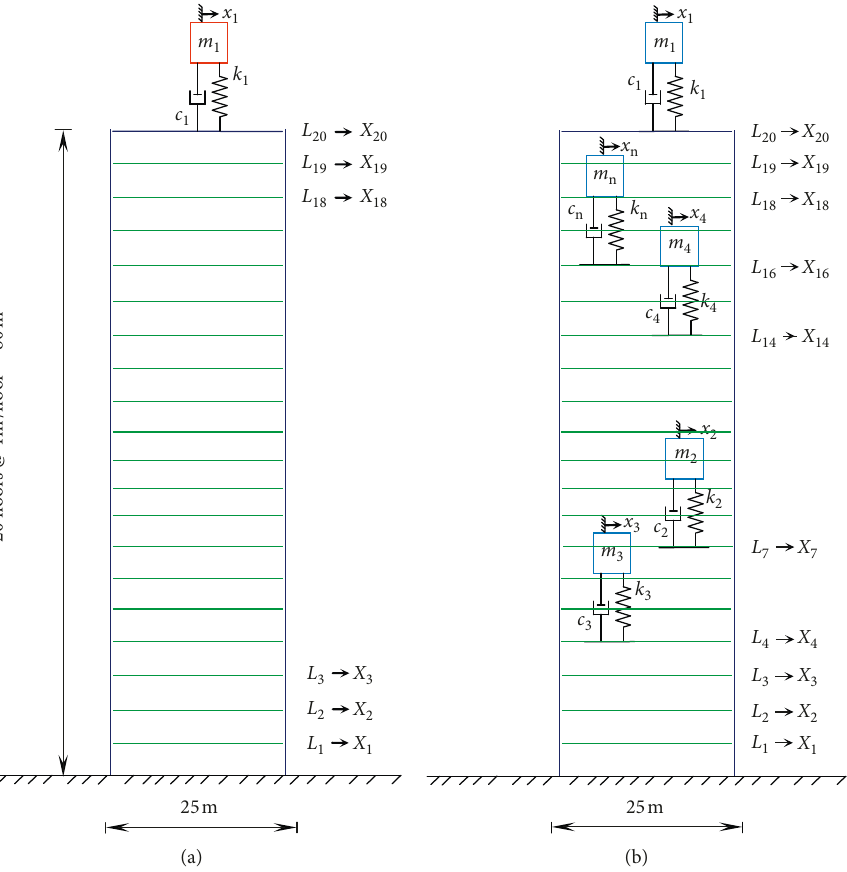
Figure 1: Model of 20-storey building installed with (a) STVA and (b)